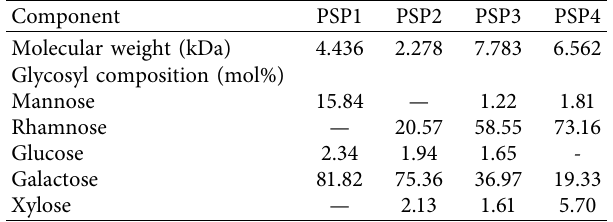
Figure 1: Ion exchange chromatography of PSP components. PSP1 was washed with deionized water, and PSP2, PSP3, and PSP4 were eluted with different concentrations of NaCl (0.05, 0.2, and 0.5M). Table 1: Molecular weight and chemical composition of PSPs.